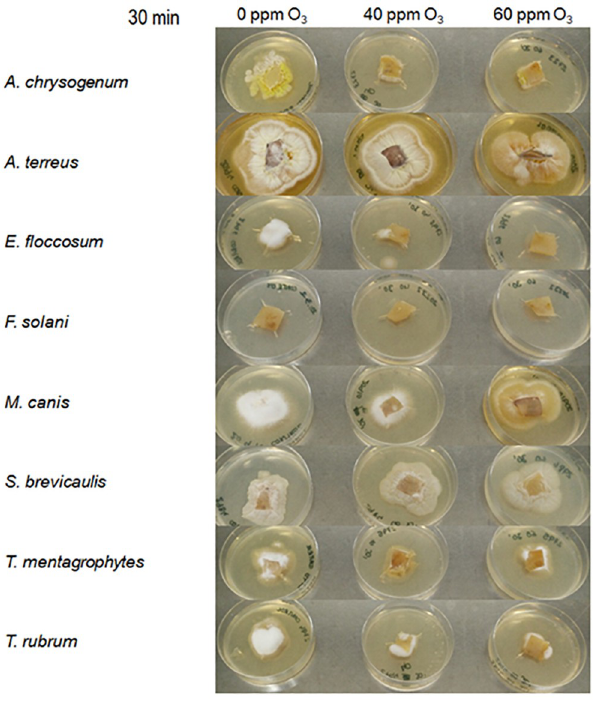
Fig 7. Growth of the eight fungal strains on porcine hooves samples placed on PDA medium, after ozone treatments at 40 ppm or 60 ppm combined with both laser wavelengths, during 30 min.